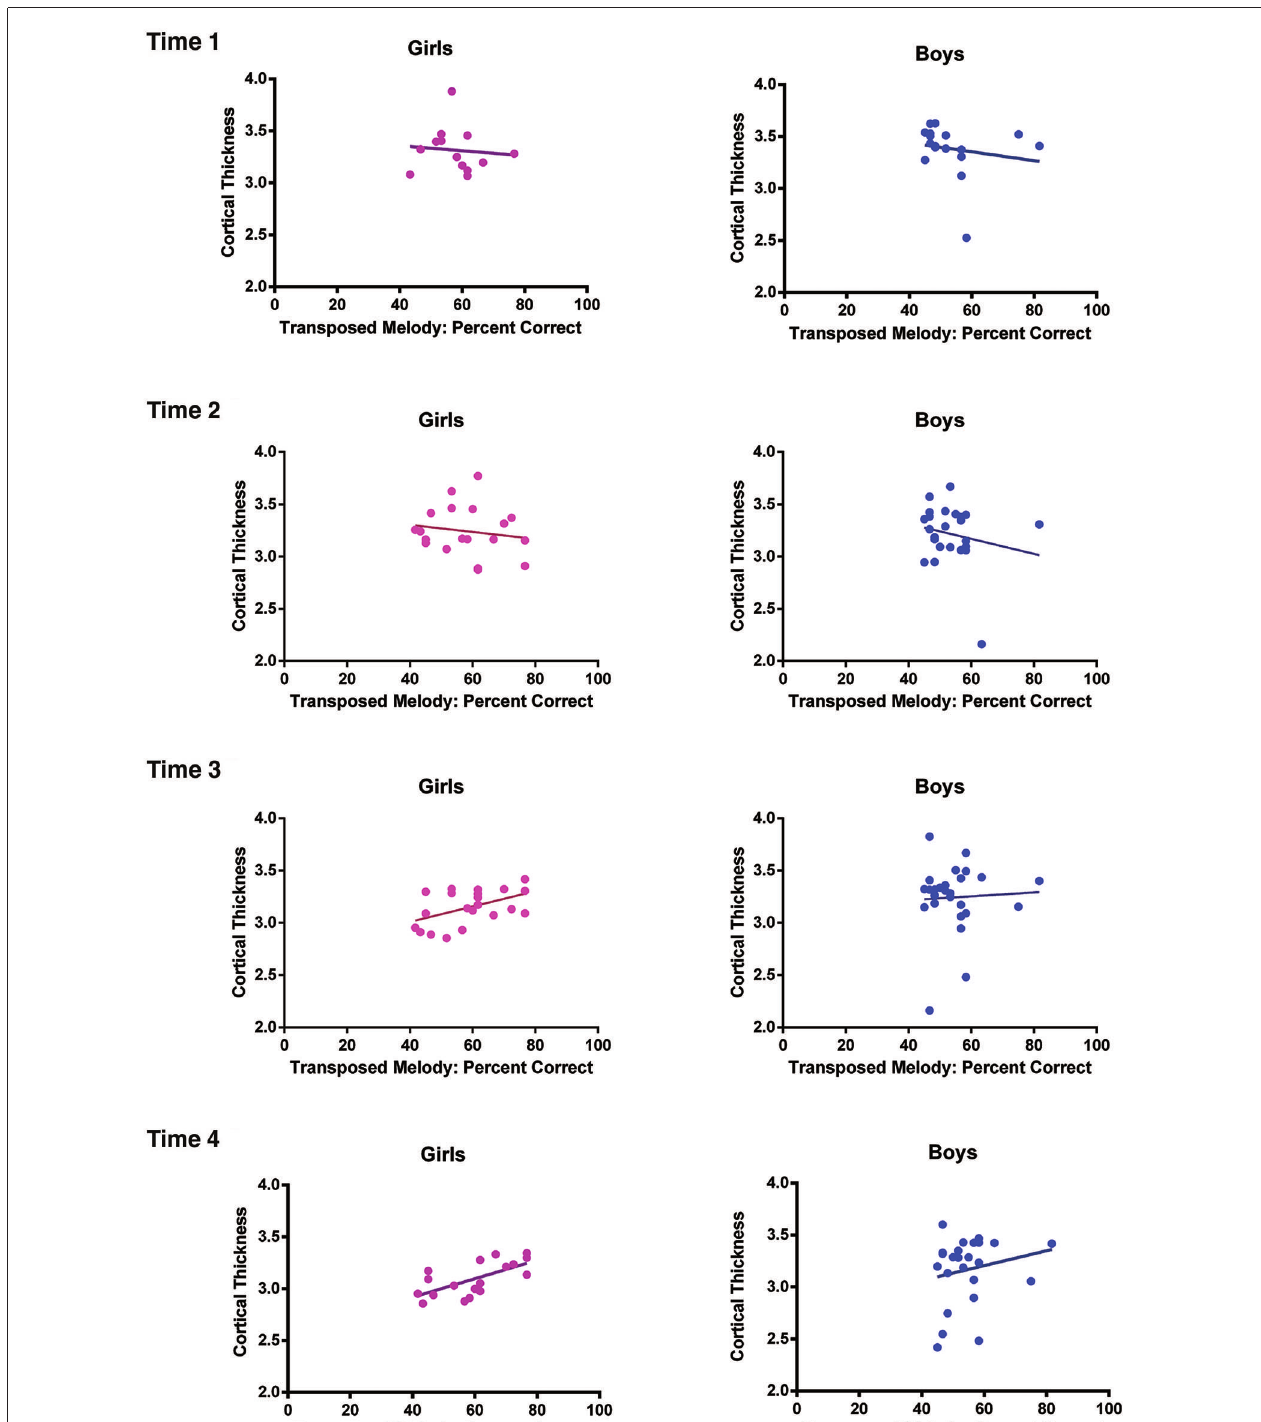
r = − .176, p = .5 for boys; At Time 2, the correlation was r = − .157, p = .52 for girls, r = − .195, p = .36 for boys; at Time 3, the correlation was r = .49, p = .02 for girls, r = .05, p = .81 for boys; and finally at Time 4, the correlation was r = .66, p = .002 for girls, r = .2, p = .35 for